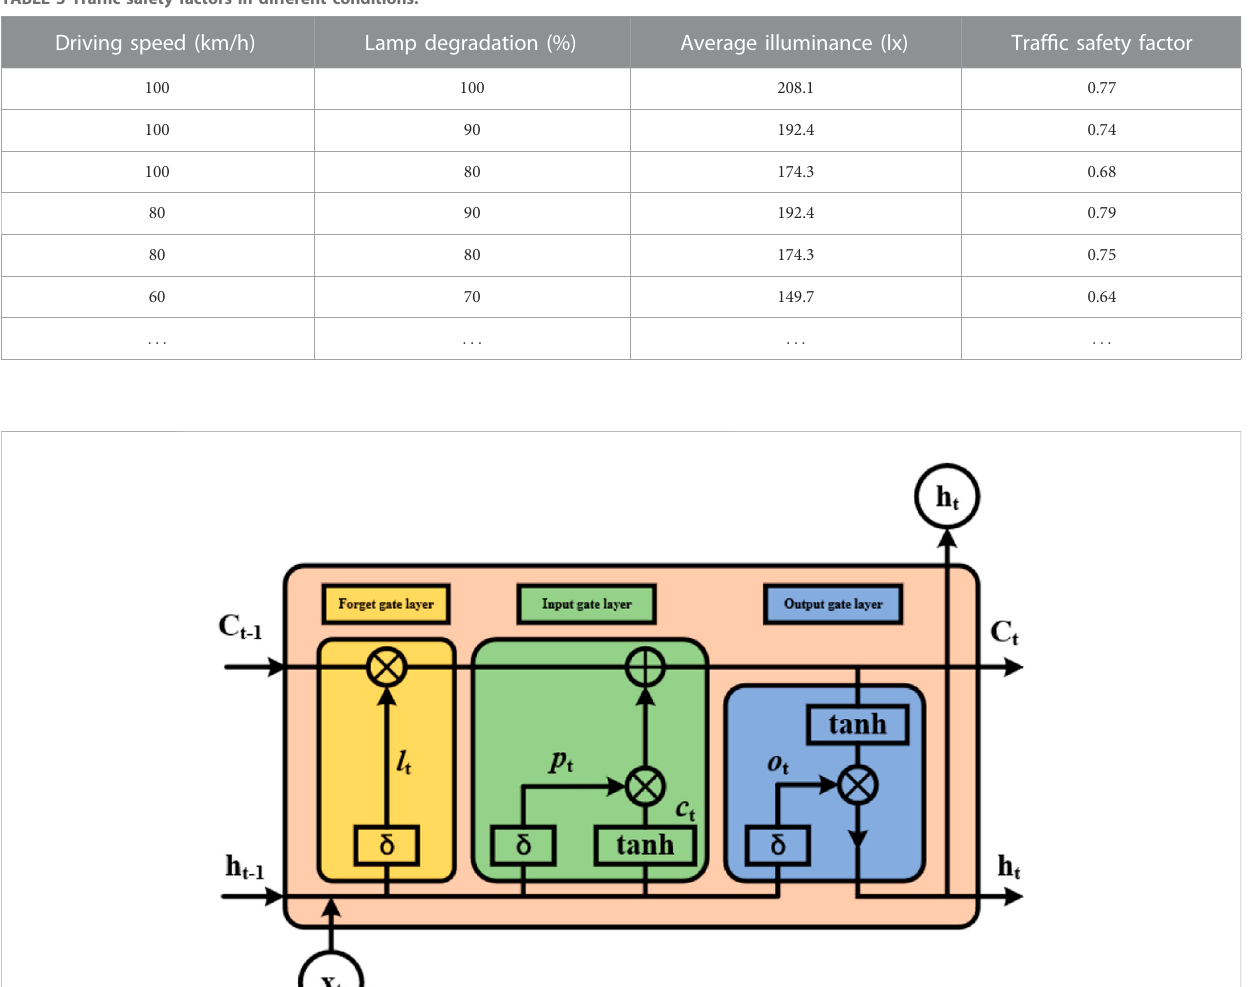
TABLE 3 Traf fi c safety factors in different conditions.